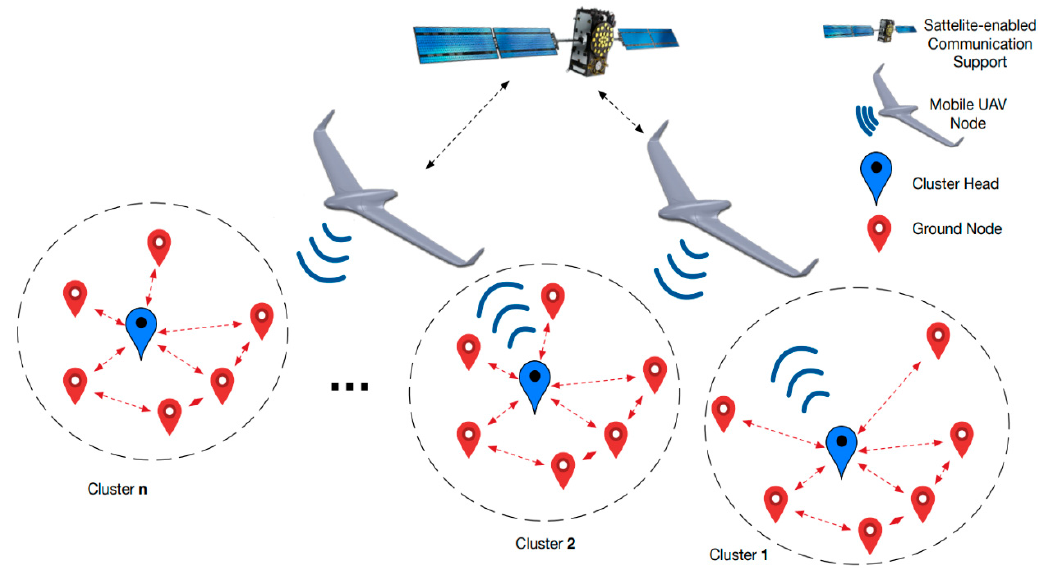
Figure 5. UAV data mule scenario among clusters of heterogeneous ground WSNs.